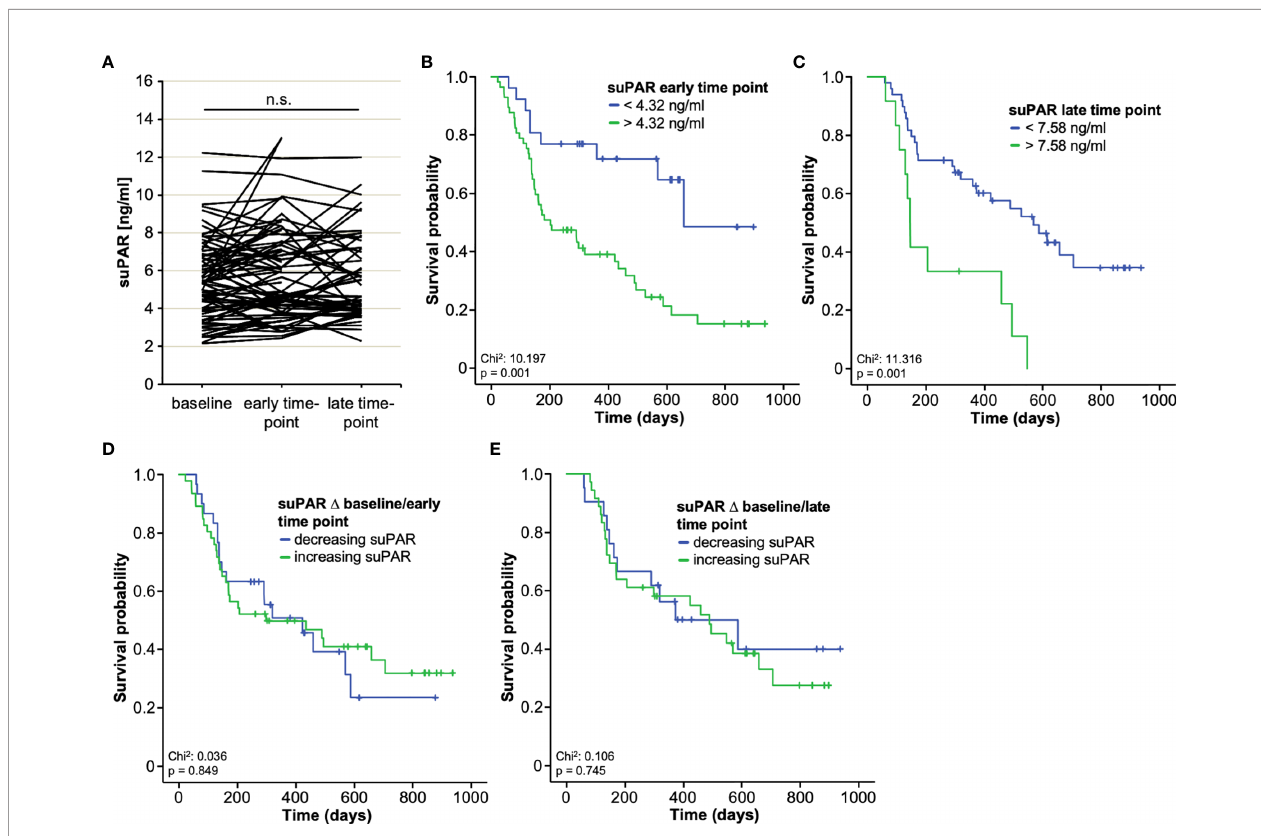
FIGURE 4 | Prognostic relevance of circulating suPAR during ICI treatment. (A) Serum suPAR levels at the early and late time point during ICI treatment are unaltered compared to initial concentrations. (B, C) Patients with suPAR serum levels above the respective optimal cut-off value (early time point: 4.32 ng/ml, late time point: 7.58 ng/ml) show a signi fi cantly impaired OS compared to patients with lower suPAR levels during the course of ICI treatment. (D, E) There is no survival bene fi t in patients who show increasing or decreasing suPAR concentrations at the early or late time point compared to baseline levels. n.s., non signi fi